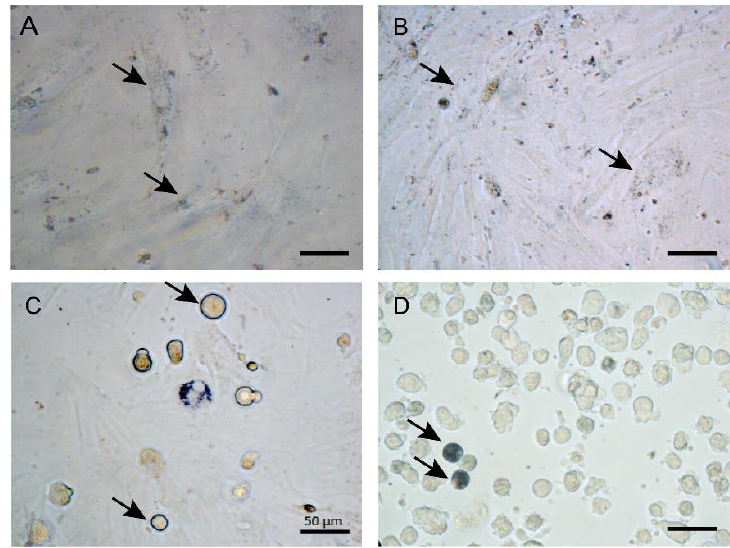
Figure 10. Adipose-derived stromal cells uptake and retention of Laser ablated Albumin function- alized AuNPs (LA-AuNPs), 2 weeks of recovery after incubation with LA-AuNPs for 24 h. ASCs nanotracer preservation with 2 nm LA-AuNPs 1:1 ( A ), 53 nm LA-AuNPs 1:1 ( B ). Enzymatic digestion of 2 nm LA-AuNPs 1:1 during the trypsin digestion ( C ), and after trypsin digestion ( D ). Nanoparticles uptake (arrows) observed dispersed on cells cytoplasm ( A , B ), as a halo on the cytoplasm of instantly detached cells (arrows, ( C )), and clusters on advanced detached cells (arrows, ( D )). Objective 40 × , scale bars 50 µ m.